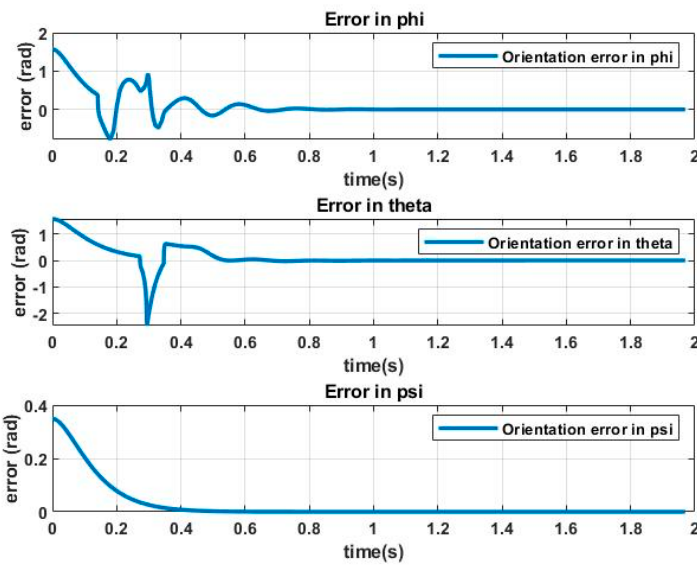
Figure 13. Relative orientation errors vs. time from task 1.